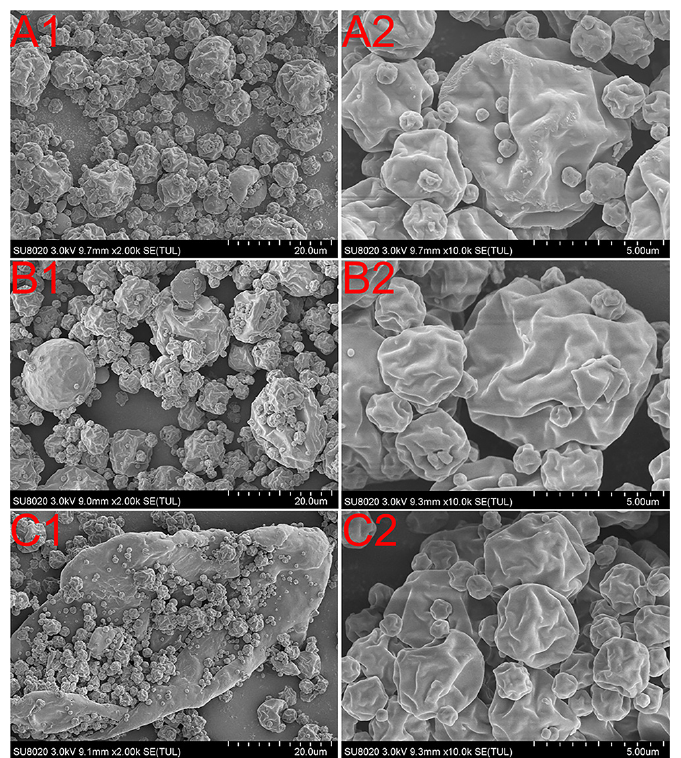
Figure 4. Scanning electron micrographs of ( A1 , A2 ) co-amorphous SDs ( B1 , B2 ) co-amorphous LM SDs at weight ratio 1:3 ( C1 , C2 ) co-amorphous MCC SDs at a weight ratio of 1:3.